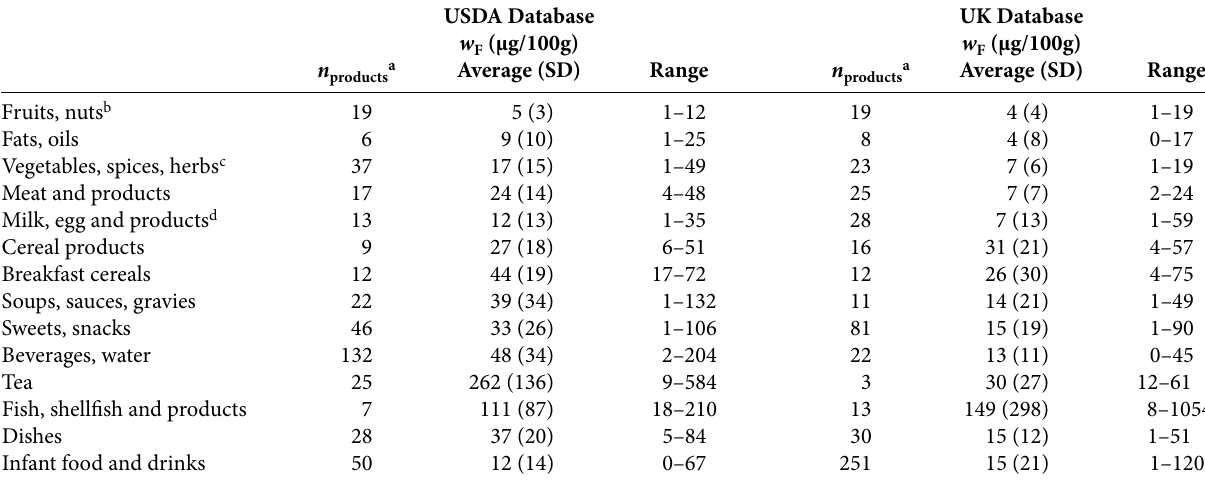
Table 1: The averages and the ranges of total fluorine contents ( w F ) in different food groups on a fresh weight basis listed in the USDA National Fluoride Database 218 and UK Fluoride Database 219,220 analyzed as ready-to-eat items